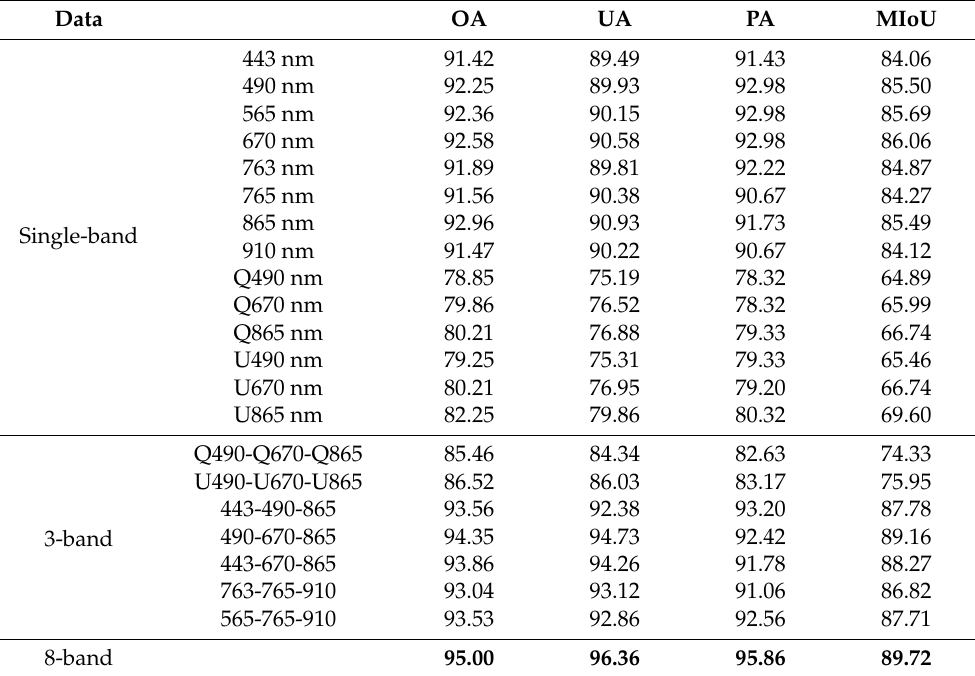
Table 5. The cloud detection accuracy (%) of different input